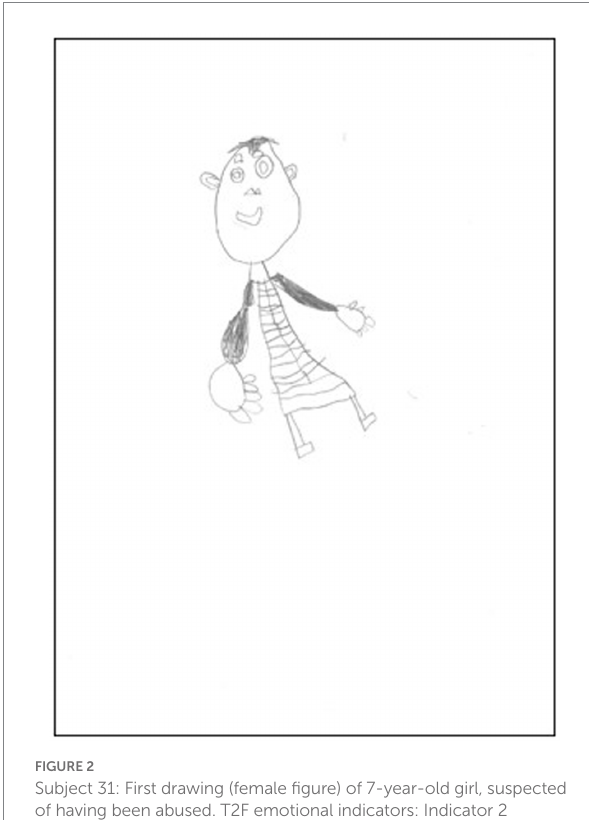
FIGURE 2 Subject 31: First drawing (female figure) of 7-year-old girl, suspected of having been abused. T2F emotional indicators: Indicator 2 (asymmetric limbs), Indicator 12 (big hands or fingers), Indicator 18 (limbs shaded) and Indicator 25 (leaning figure).